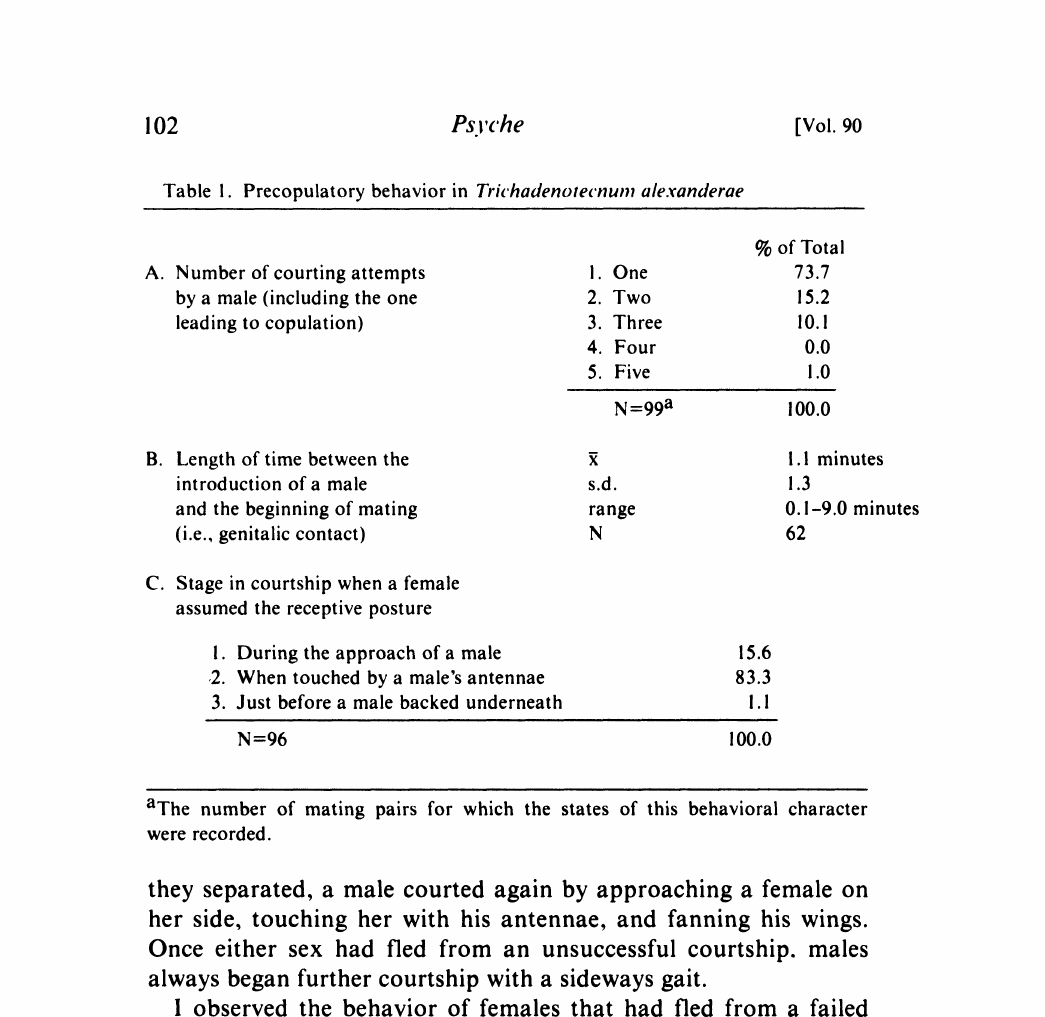
Table I. Precopulatory behavior in Trichadenotecnum alexanderae